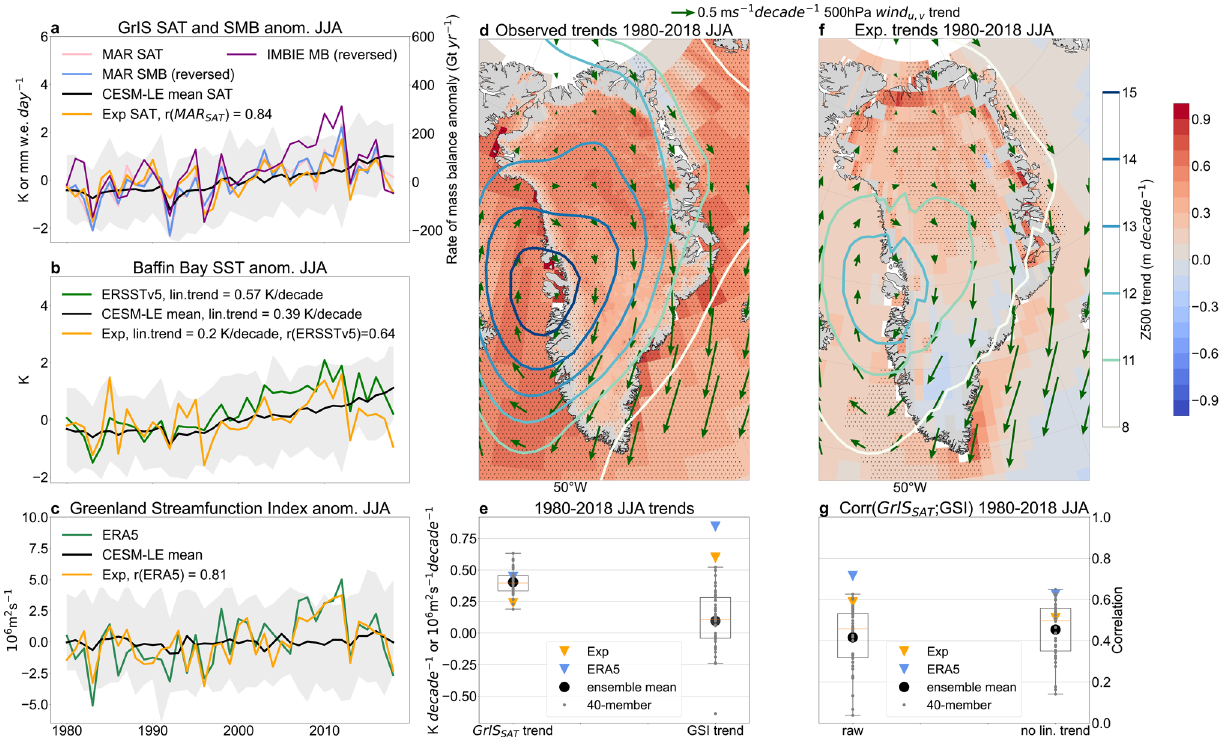
Fig. 1 | Observed and simulated circulation-driven GrIS summer surface con- ditions over 1980 – 2018. a Greenland ice sheet (GrIS) spatial-averaged time series of anomalies in MARsurface air temperature(SAT, pink)and surface massbalance (SMB,blue),theensemblemeanSATfromCESM1largeensemble(CESM-LE,black) andtheSATfromthewind-nudgingexperiment(Exp)inCESM1(orange)insummer (June – July – August, JJA) as well as the observed annual rate of total GrIS mass change(IMBIE)(purple).Thegreyshadingin a representstherangeofallmembers ’ SAT anomalies from the CESM-LE. In b , ERSSTv5 sea surface temperatures (SST) averaged over the Baf fi n Bay (60° − 80°N; 50° − 70°W) (green) is compared with the onescalculated using the CESM-LEmean(with black),the spreadin CESM-LE(grey shading)andthewind-nudgingexperiment(Exp,orange)forJJA. c issameas b ,but for the 500hPa Greenland streamfunction index (GSI, Methods). In d , spatial maps